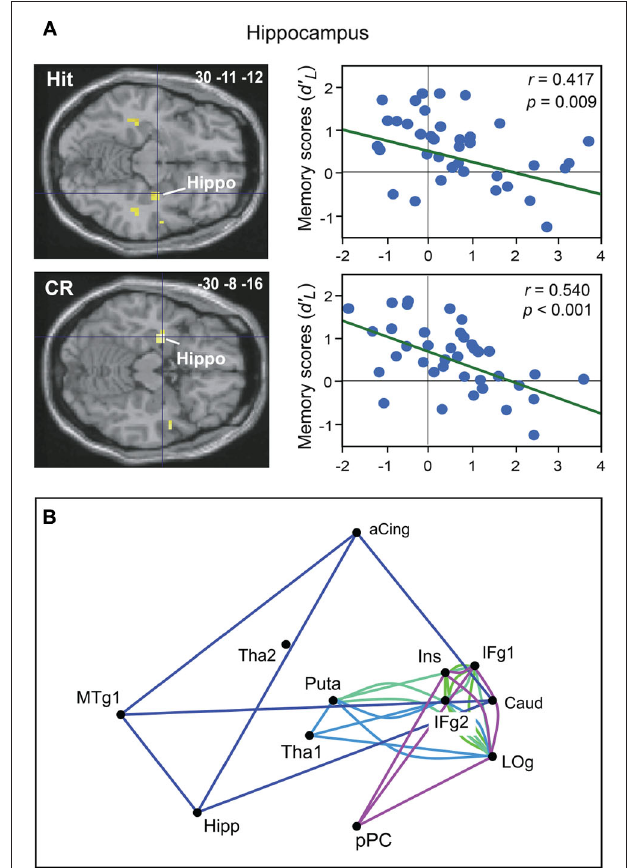
FIGURE 3 | Neural basis of odor recognition memory. (A) Decreased activation intensity in the right and left hippocampus as a function of memory scores ( d’ L ) for Hit and CR in all participants (adapted from Royet et al., 2011). (B) The module in dark blue shows four regions functionally connected during the Hit condition. Other modules were also found during the CR, Miss or False alarm conditions. aCing, anterior cingulate; Caud, caudate nucleus; Hipp, hippocampus; IFg, Inferior frontal gyrus; Ins, insula; LOg, lateral orbital gyrus; MTg, medial temporal gyrus; pPC, posterior piriform cortex; Puta, putamen; Tha, thalamus (adapted from Meunier et al.,